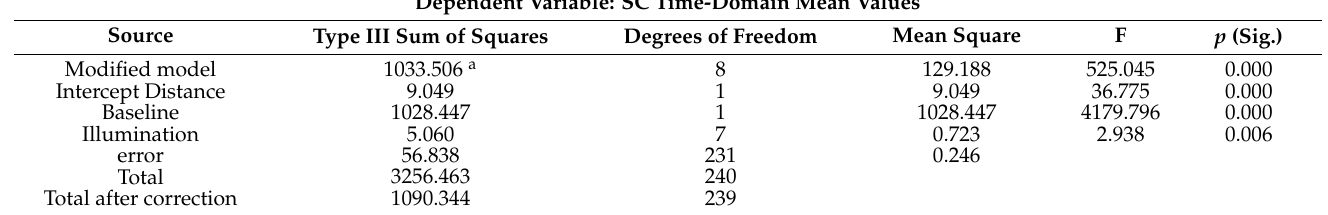
Table 3. Between-subjects effects test.